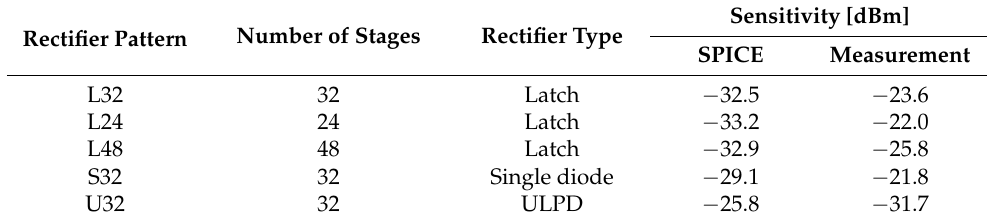
Table 4. Measurement result of the sensitivity of each rectifier.